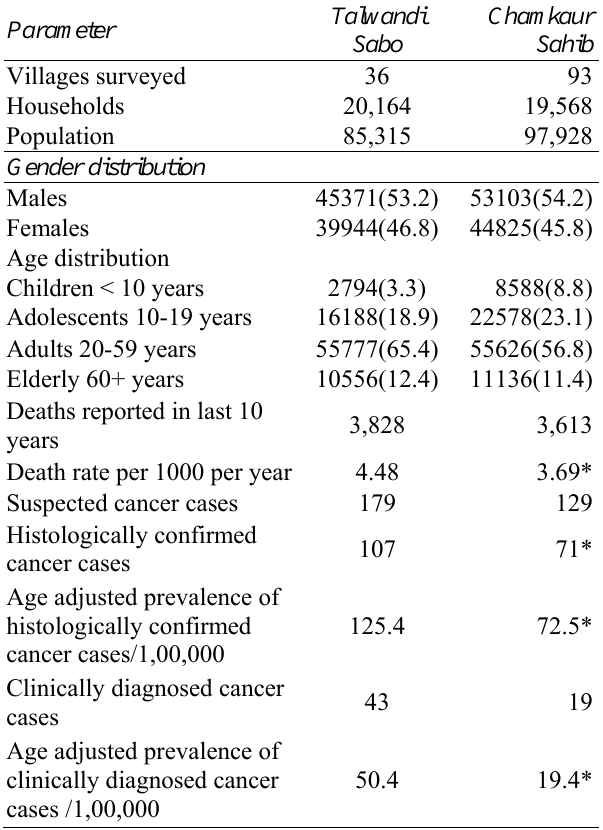
Table 1: Distribution of Cancer Morbidity and